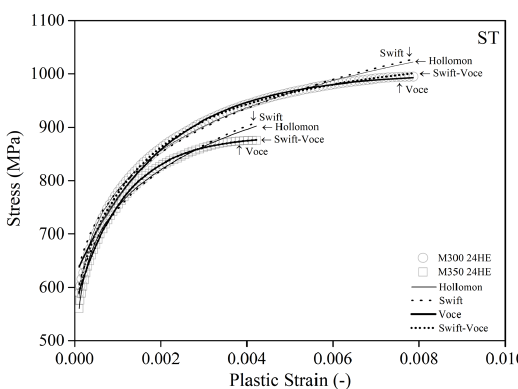
Figure 8. Curve fitting approach using different models for ST maraging steels by 24HE